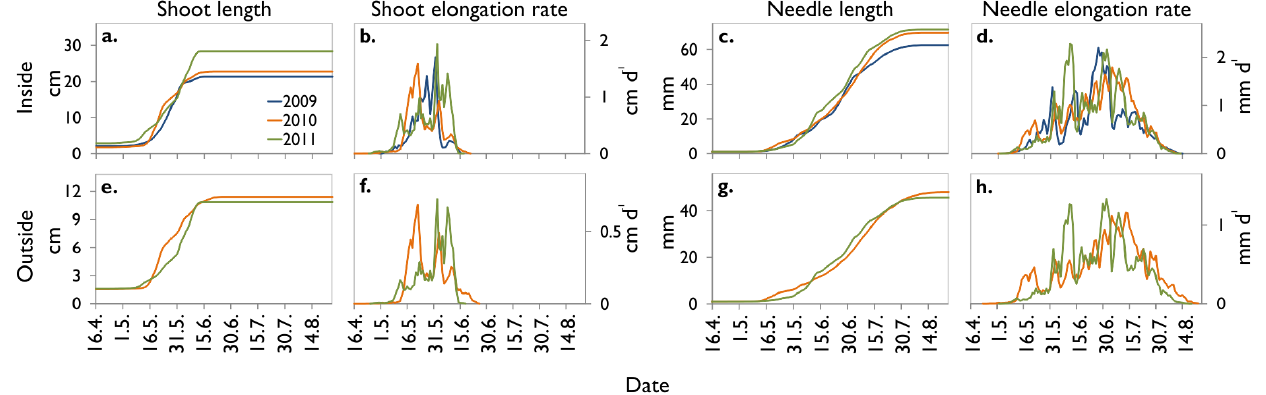
Fig. 4. The shoot and needle lengths and elongation rates during growing seasons 2009–2011. (a–d) inside, (e–h) outside the shoot enclosure. The needle and shoot elongation outside the enclosure was not measured during the growing season